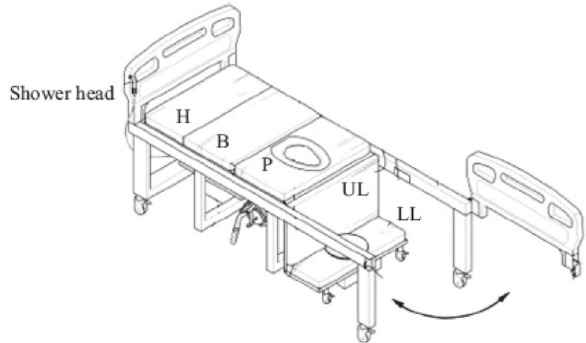
Fig. 2 Bed with integrated toilet [34]. H: head plate, B: back plate, P: pelvis plate, UL: upper leg plate, LL: lower leg